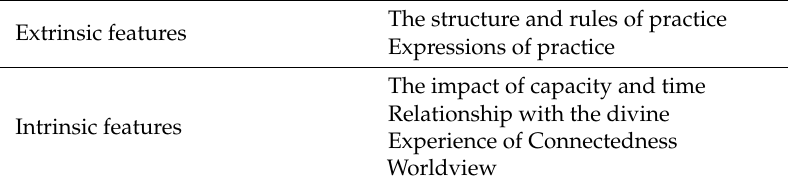
Table 2. A summary of themes identified within the participants’ descriptions of their religious